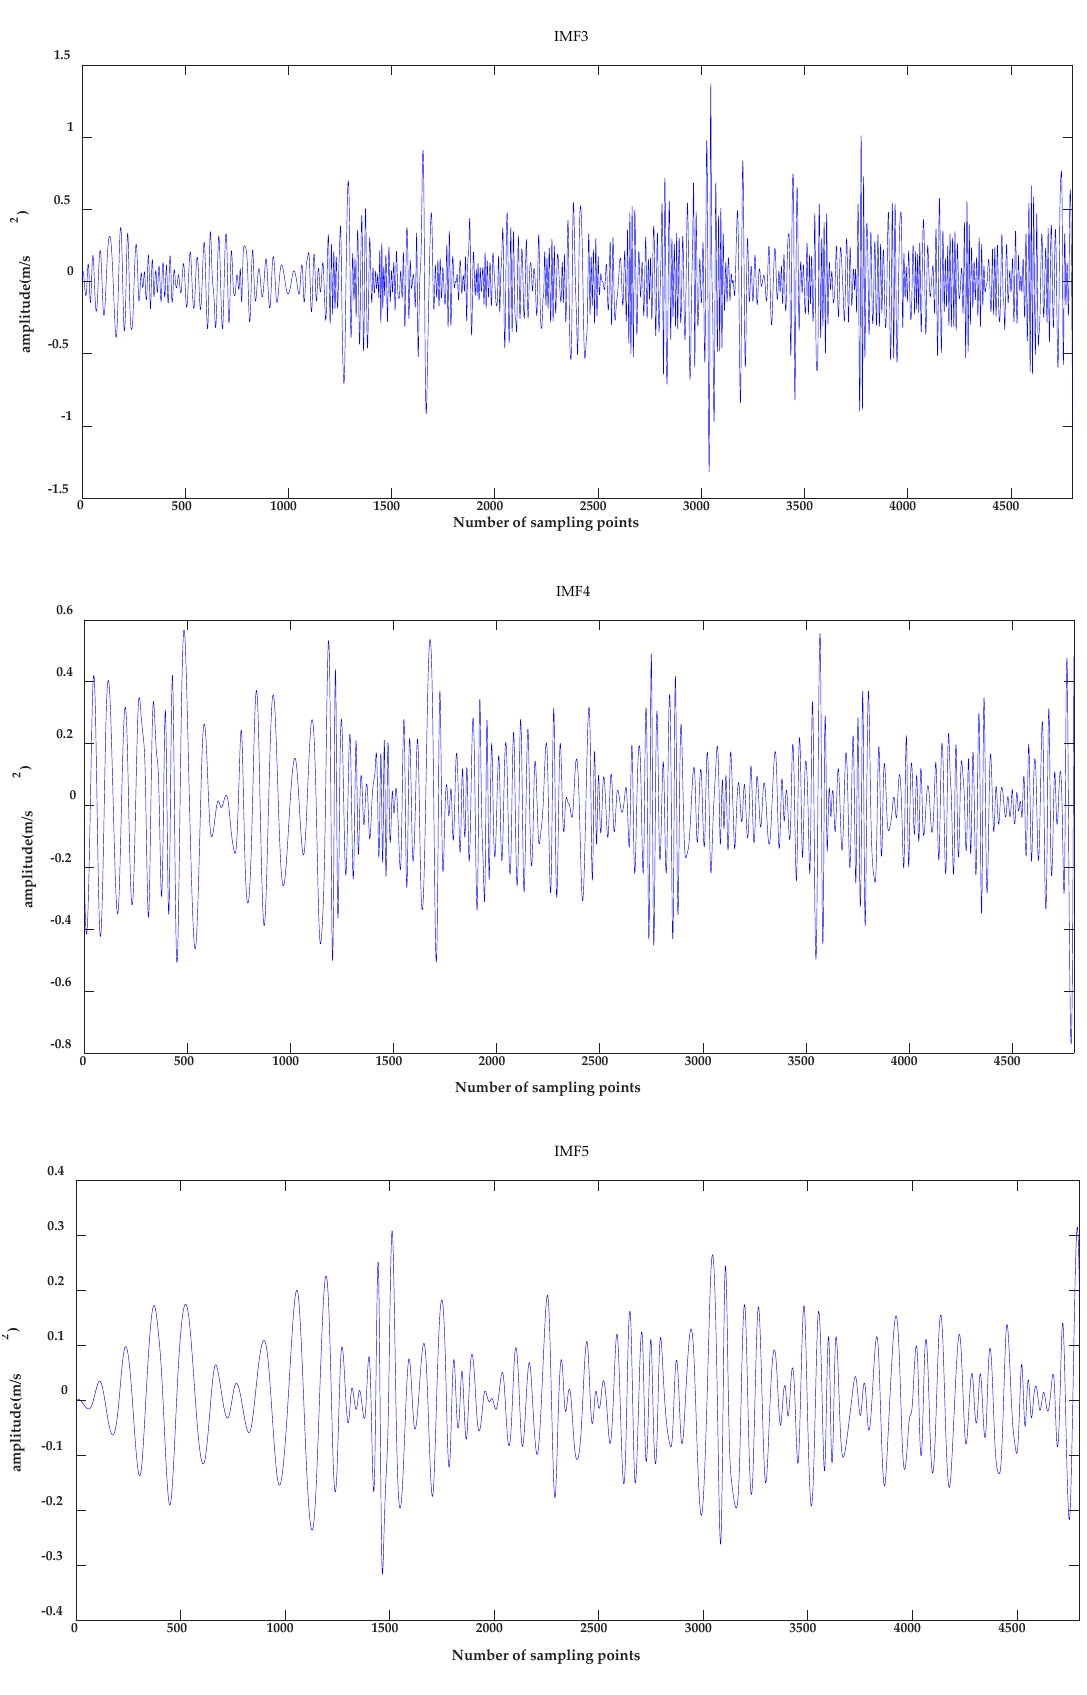
Figure 4. The results of EMD decomposition.